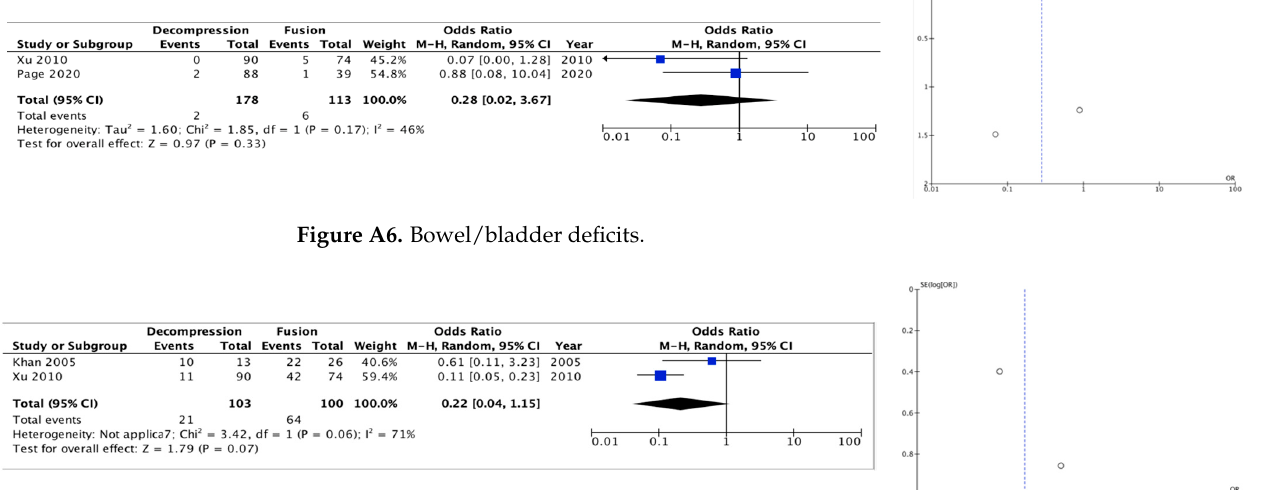
Figure A7. Pre-op spondylolysthesis.